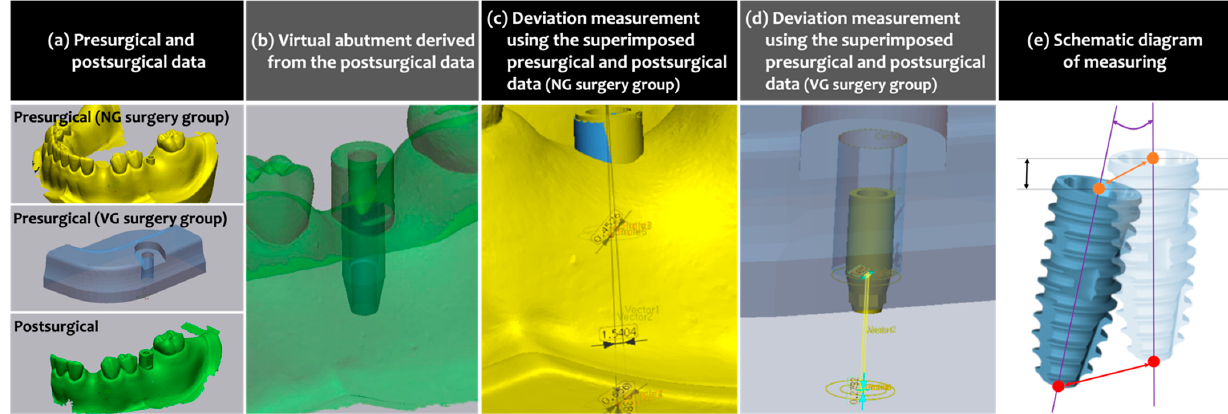
Figure 3. Accuracy of implant position measurements. ( a ) Presurgical and postsurgical data. The presurgical data of the NG and VG groups were extracted from the respective computer software, and the postsurgical data were obtained by optical impression taking following the scan body application in both groups. ( b ) The abutments virtually designed over the actually placed implant. ( c , d ) Measuring the deviation between the virtually planned and actually placed implants after superimposing the presurgical and postsurgical data. ( e ) Schematic diagram showing the method of measuring the deviation between the virtually planned (transparent fixture) and actually placed (vivid fixture) implants: vertical deviation (mm; black double-headed arrow) measured as the distance between two black parallel lines passing the center of the fixture platform; angular deviation (°; purple curve) between the purple lines representing the long axis of the implants; platform deviation (mm; orange double-headed arrow) between the orange dots showing the centerpoint of the fixture platform; apex deviation (mm: red double-headed arrow) between the red dots showing the centerpoint of the fixture apex.